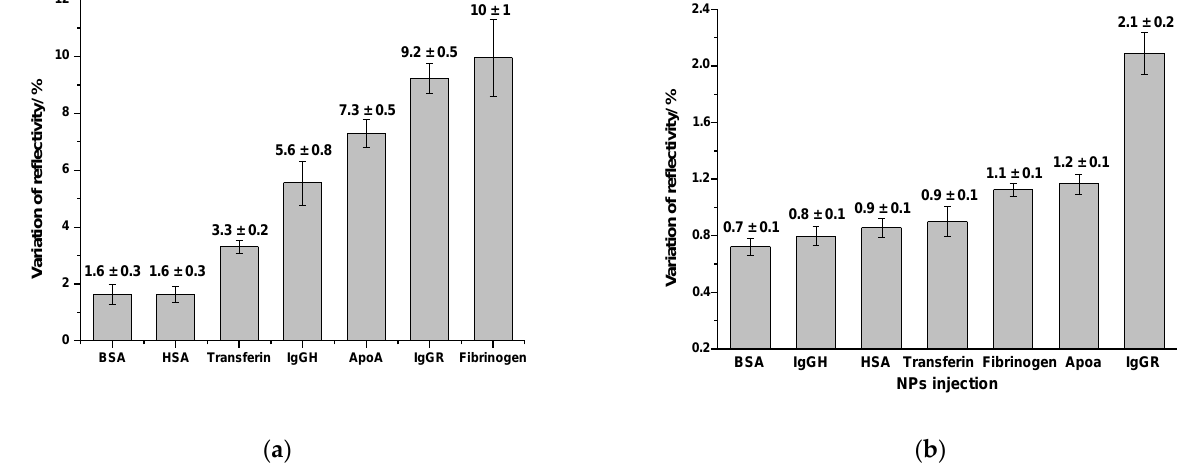
protein. These values were calculated by subtracting the initial value of reflectivity of the baseline from the value of reflectivity after the dissociation phase. The evaluation of the variation of reflectivity provides insight into the extension of the adsorption of NPs on each type of protein. The higher the adsorption, the higher the affinity between the protein and NPs.